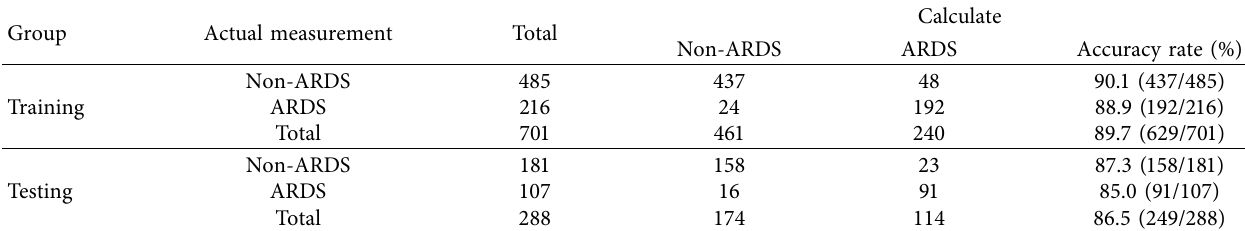
Table 2: Accuracy of ARDS prediction in CAP patients based on training and testing datasets from ANNs. Group